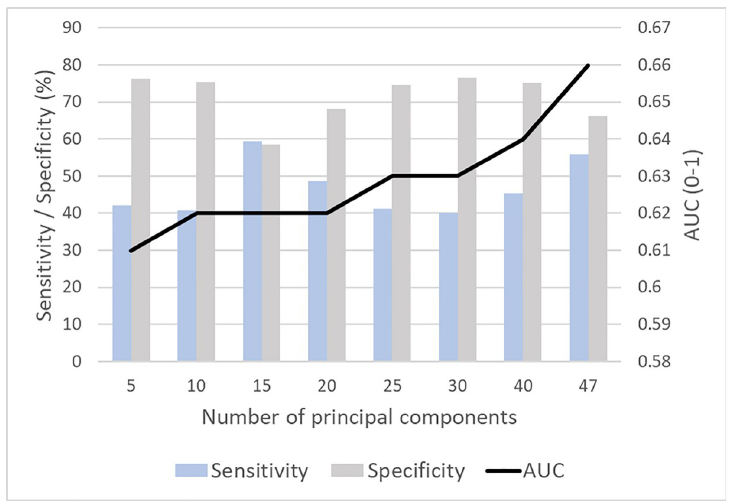
Fig 1. Performance of the multi-layer perceptron (MLP) prediction model on variables generated by principal component analysis.